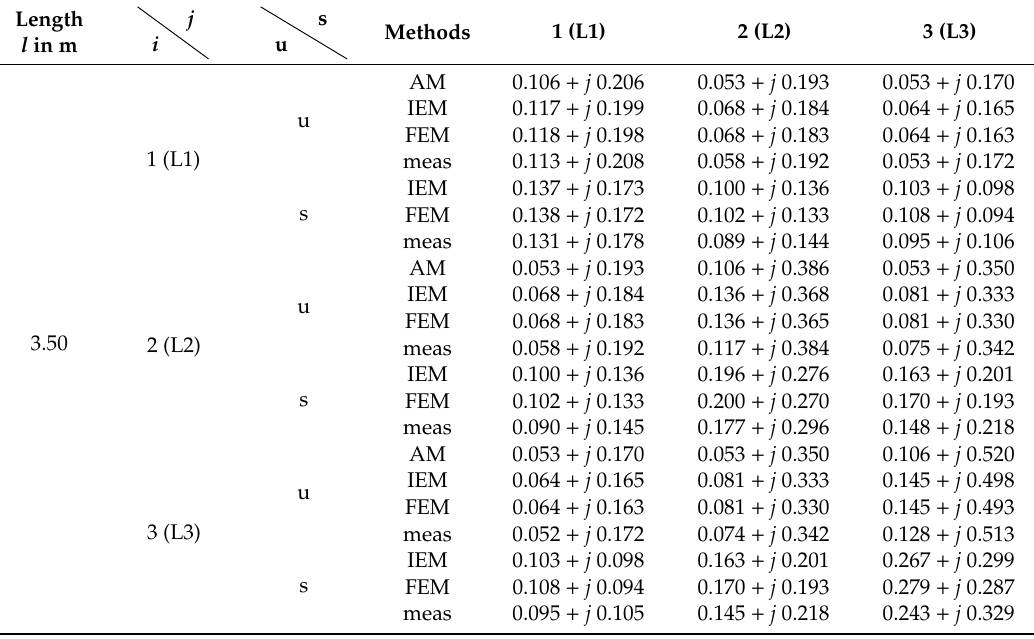
Table 2. Reduced self and mutual impedances in m Ω of the unshielded (u) and shielded (s) three-phase busbar systems illustrated in Figures 2 and